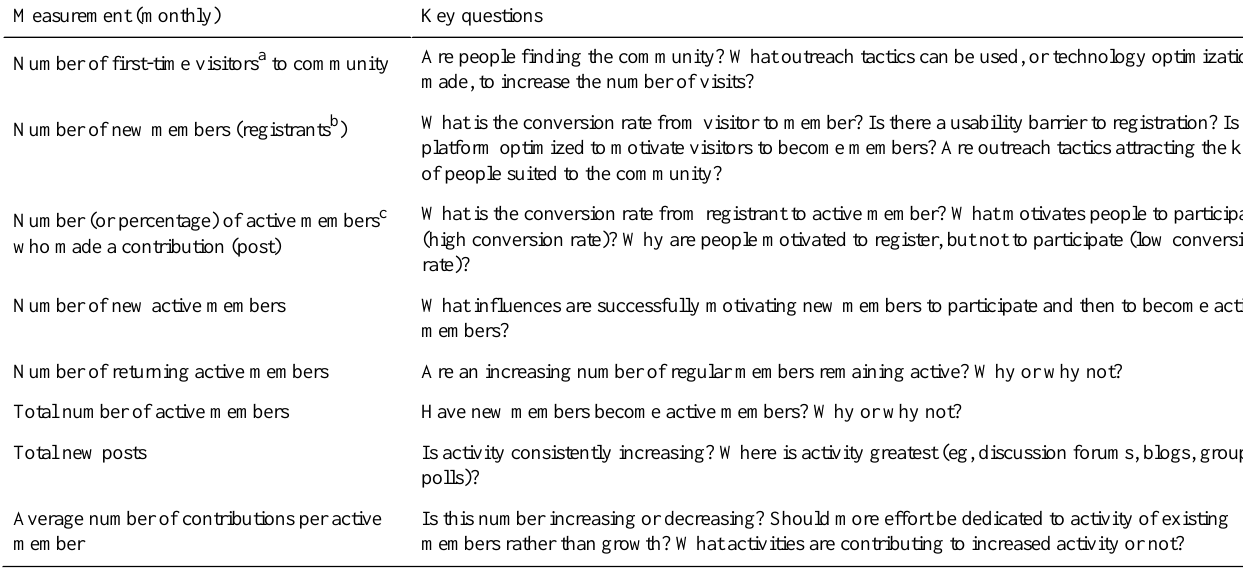
Table 2. Examples of growth and activity data that community managers could collect. Key questionsMeasurement (monthly) Are people finding the community? What outreach tactics can be used, or technology optimizations visits?Number of first-time visitors a to community made, to increase the number of What is the conversion rate from visitor to member? Is there a usability barrier to registration? Is the of people suited to the